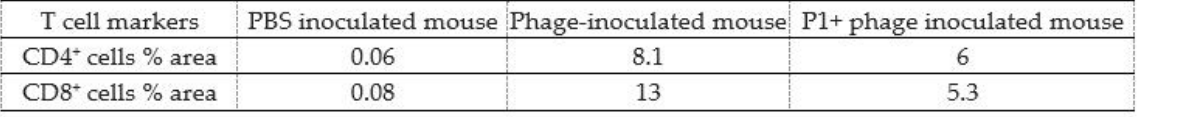
Figure 10. ( A ) Detection of CD4 + and CD8 + T cells in mouse lungs by immunohistochemistry analysis: The brown color in the images of mice that received recombinant phages and mice that received P1+ recombinant phages is indicative of the presence of CD4 + and CD8 + T cells in the lungs (5 to 13 percent area), whereas almost no color change was seen in the mouse injected with PBS (% area < 0.08). ( B ) Quantitative analysis of the area with T CD4 + and T CD8 + cells was performed using Image J software and reported as percent area for each image in the table.